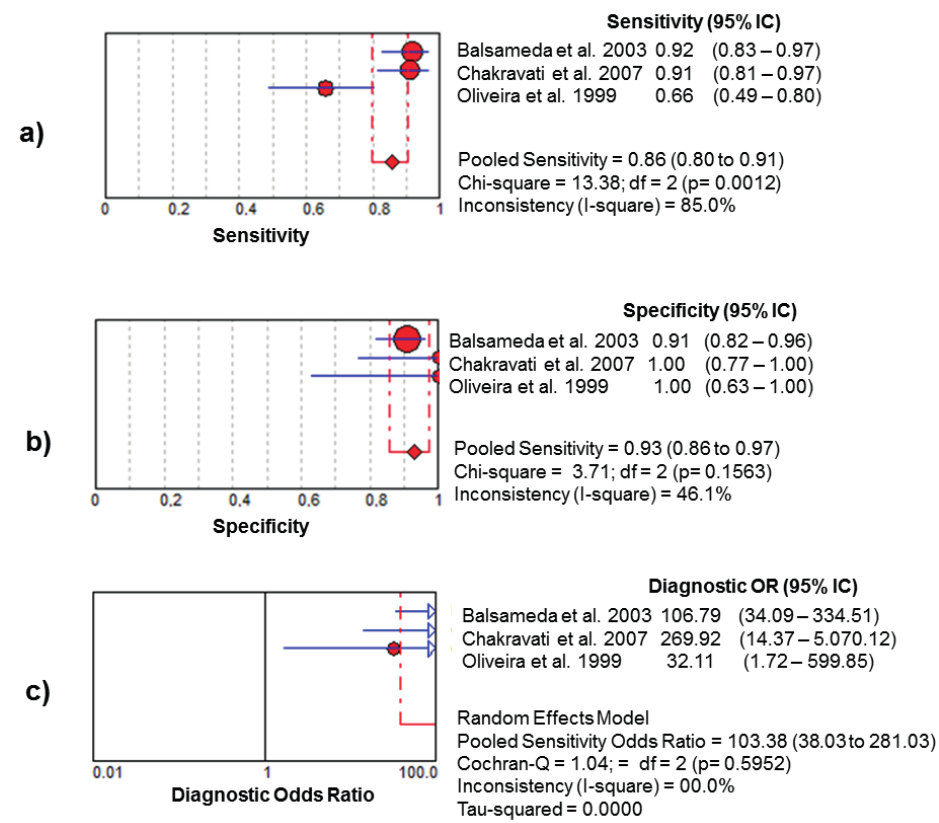
Figure 3 - Forest plot of sensitivity, specificity and diagnostic odds ratio of IgM.